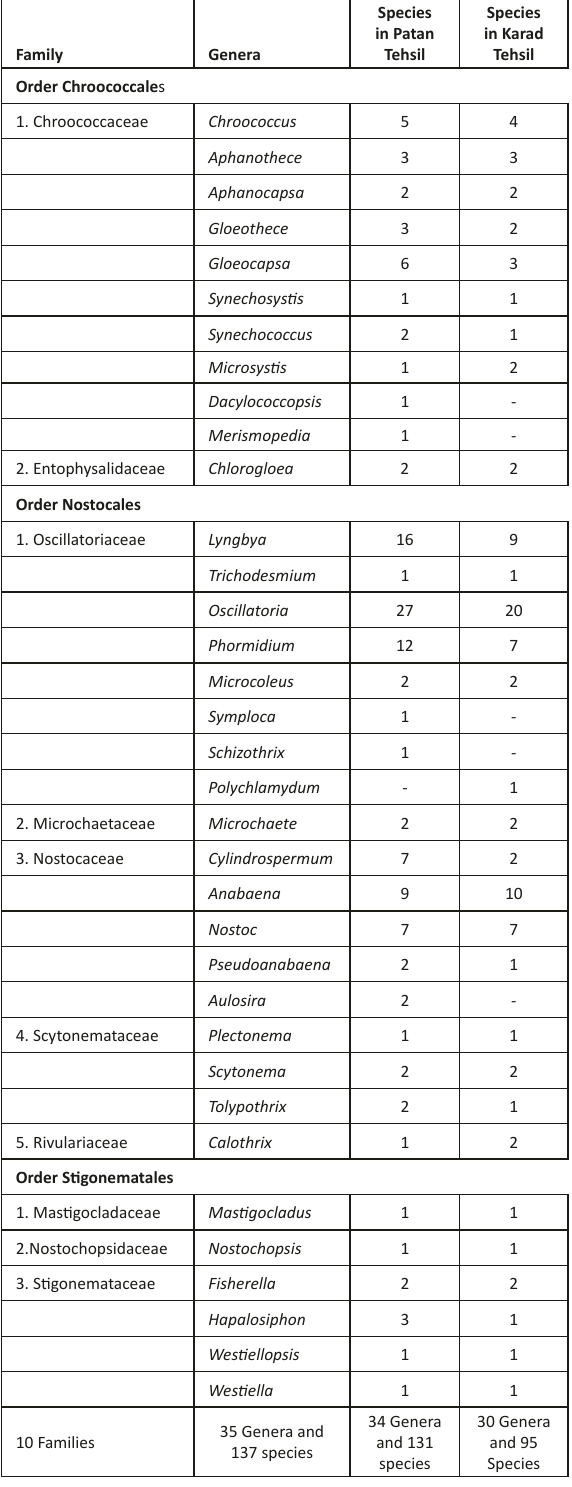
Table 1. Total number of species from Patan and Karad tehsils.